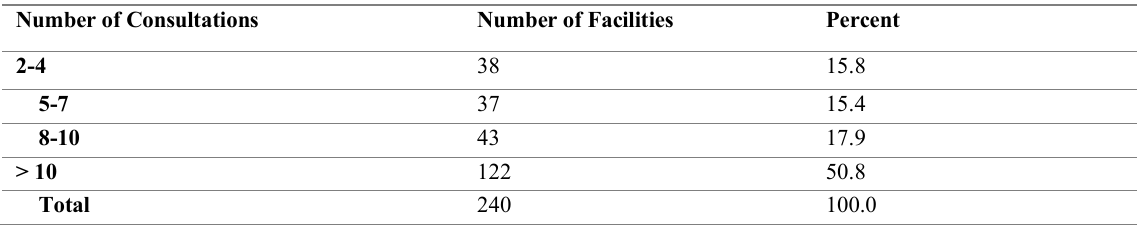
Table 2: Frequency of Consultations by the most Frequent